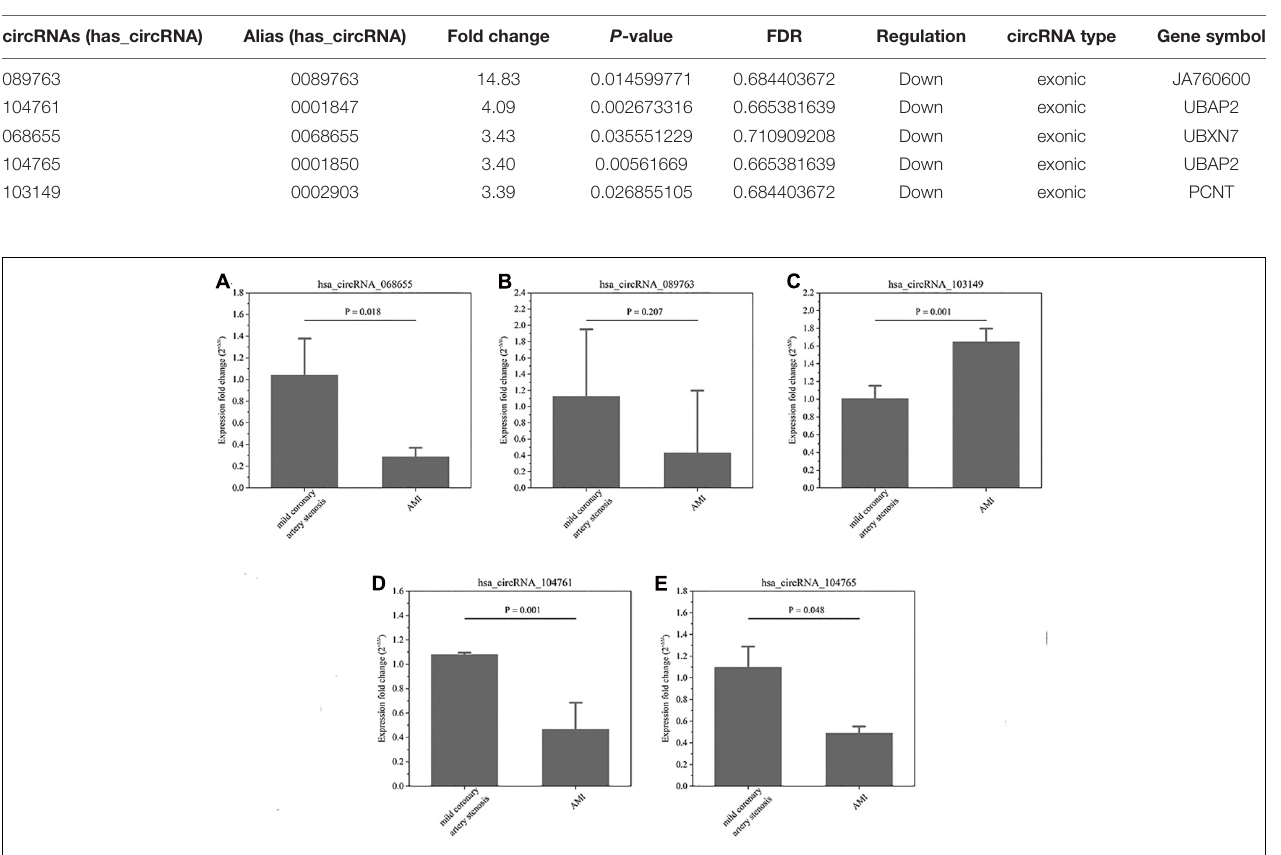
FIGURE 3 | (A–E) The relative expression of circRNAs. In-situ verification of the relative expression level of 5 down-regulated circRNAs (068655, 089763, 103149, 104761, and 104765) by RT-qPCR. Results are represented as means ± standard deviation (SD). Data shown in the graphic was analyzed by independent sample t tests with a significance level of